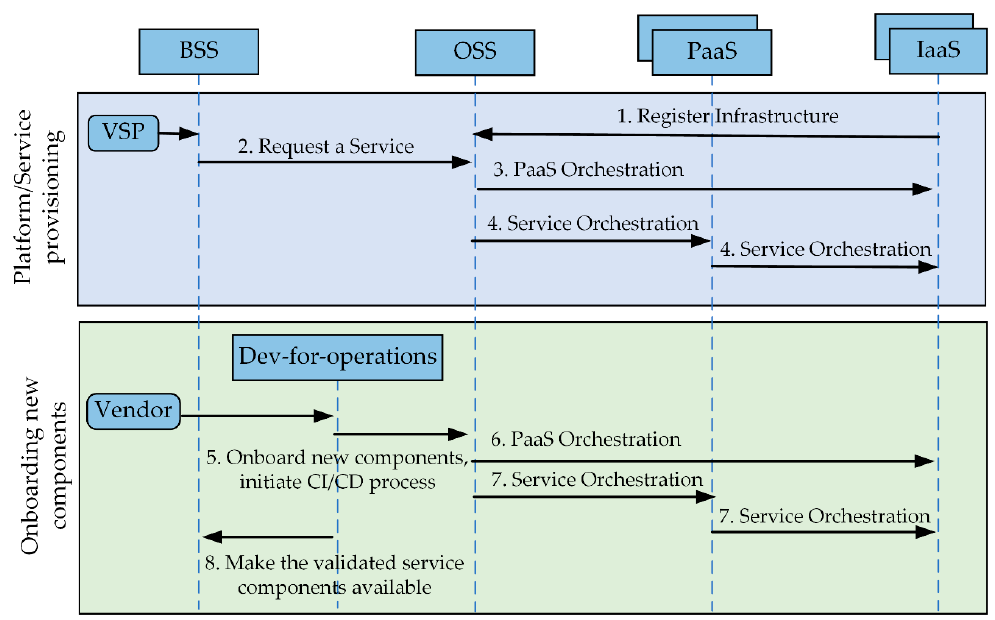
Figure 5. NGPaaS processes, to enable a customisable platform.